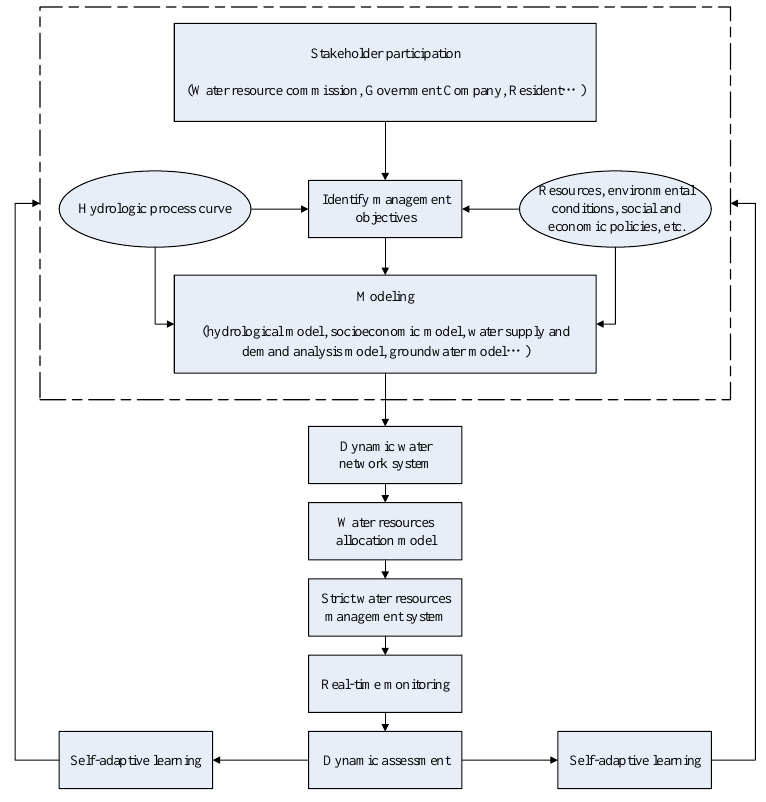
Figure 10. Water resources adaptive governance frame in China.